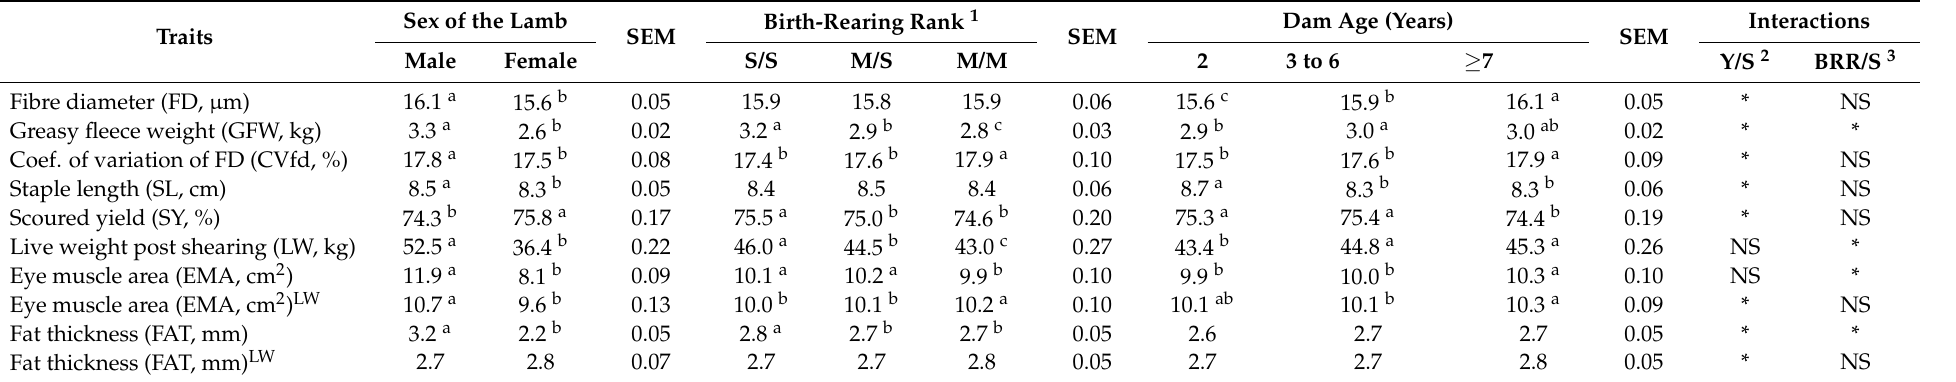
Table 5. One-year-old lamb means ( ± SEM) fiber diameter (FD, µ m), greasy fleece weight (GFW, kg), coefficient of variation of fiber diameter (CVfd, %), staple length (SL, cm), scoured yield (SY, %), live weight post-shearing (LW, kg), eye muscle area (EMA, cm 2 ) and fat thickness (FAT, mm) by sex of the lamb, birth-rearing rank, dam age and the interactions between sex of the lamb and either year or birth-rearing rank